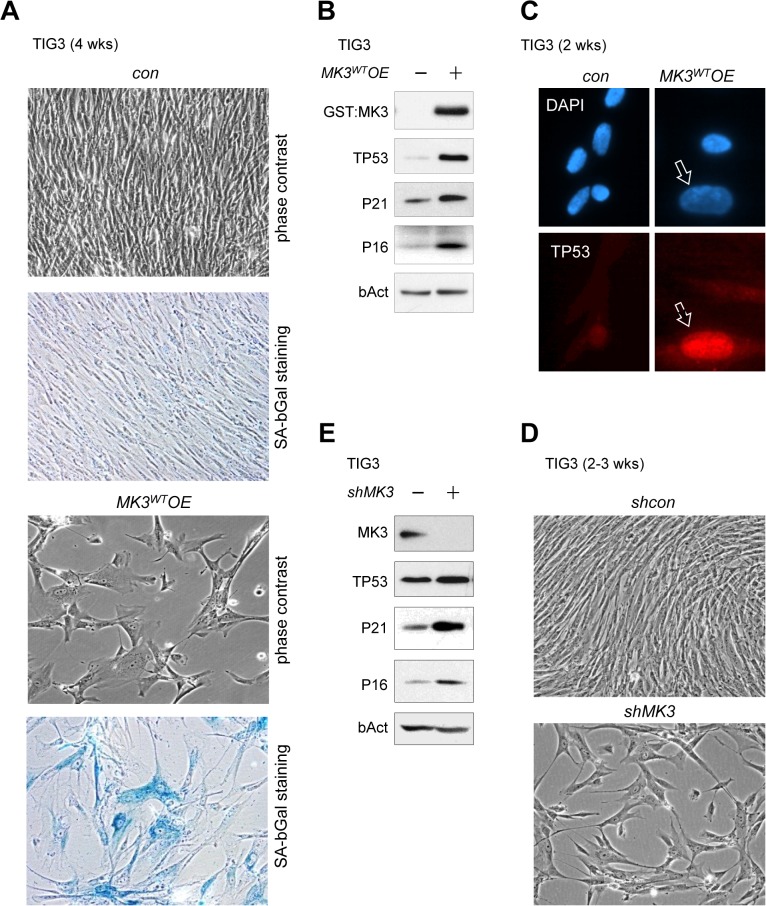
The MK3
WT
OE-induced proliferative block in normal cells correlates with induction of known senescence markers.(A) Cell morphology in TIG3/MK3
WT
OE cells (phase contrast; right upper panel); senescence-associated beta-Galactosidase (SA-bGal) staining in TIG3/MK3
WT
OE cells (right lower panel). (B) Protein expression levels of MK3, TP53, P21CIP1/WAF1 (P21) and P16INK4A (P16) in TIG3/MK3
WT
OE (MK3
WT
OE) versus control (con) cell lysates; loading control: b-Actin (bAct). TIG3/MK3
WT
OE cells were cultured for approximately 3–4 weeks prior to extraction. (C) Nuclear TP53 accumulation in senescent TIG3/MK3
WT
OE cells; counterstaining: DAPI. (D) Phase contrast images showing cello morphology in TIG3/shMK3 cells (shMK3, lower panel; phase contrast) versus control cells (shcon; upper panel). Retrovirally transduced TIG3 cells (shcon and shMK3) were submitted to puromycin selection for 3–4 days, and plated at equal density (20–25% confluency) at the onset of the experiment; pictures were taken when shcon cells reached confluency. (E) Analysis of protein expression in TIG3/shMK3 and control (shcon) cell lysates: TP53, P21CIP1/WAF1 (P21) and P16INK4A (P16); loading control: b-Actin (bAct).